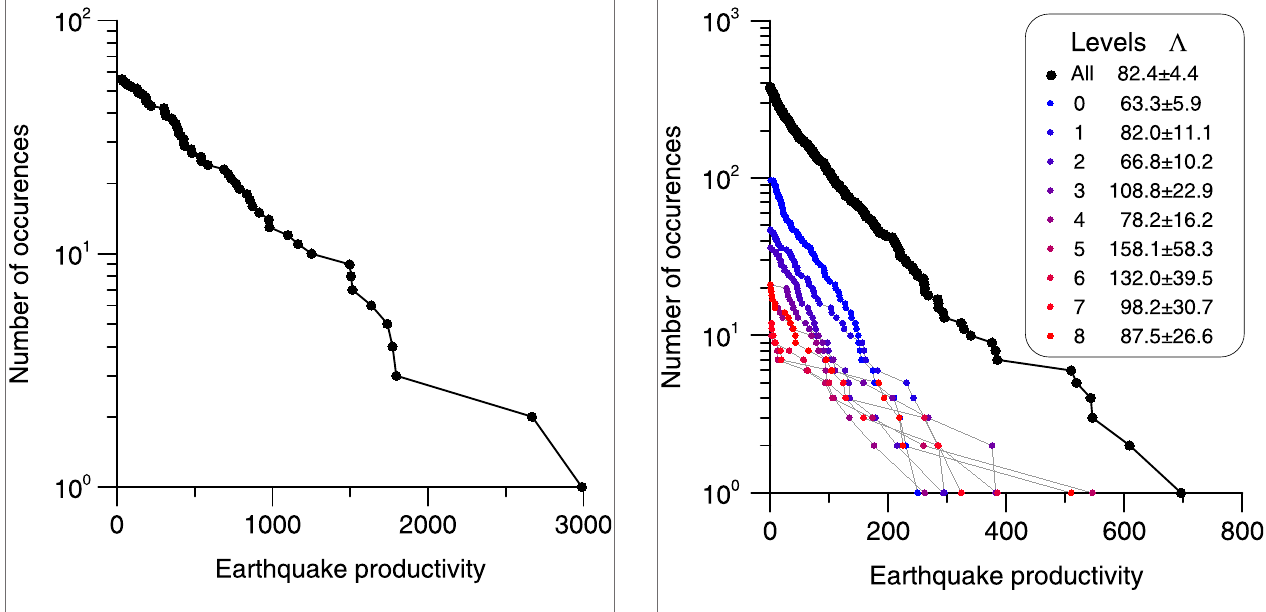
FIGURE 3 | Cumulative frequency-productivity graphs for parent earthquakes with M m ≥ 5 and offspring events with M a ≥ M m − 4: all earthquakes and separately for 8 highest hierarchy levels. Tab at the top shows the estimates of Λ 4 and its standard errors calculated by bootstrap